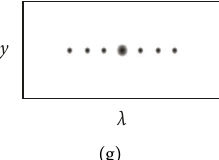
Figure 1: Schematic illustration of the apparatus. The purple line represents the microscope. (a) Fluorescence microscopy mode. VBG: volume Bragg grating. BP: band-pass filter. DC: dichroic filter. LP: long-pass filter. HM: half mirror. (b) Fluorescence image of the sample. (c) Spatial selection of a single crystal by the slits of the monochromator. (d) Fluorescence spectrum of the selected crystal. (e) Ultralow- frequency Raman microscopy mode. (f) Spatial selection of a single crystal by the slits of the monochromator. (g) Raman spectrum of the selected crystal.